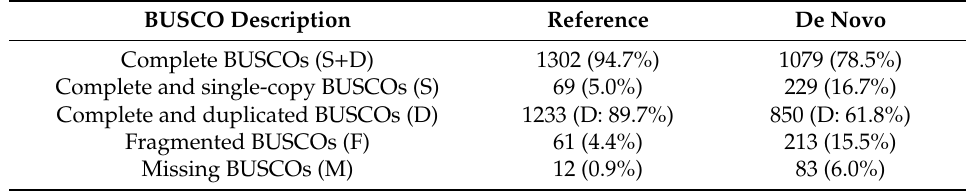
Table 2. Results of the BUSCO analysis for the transcriptome assemblies’ validation.